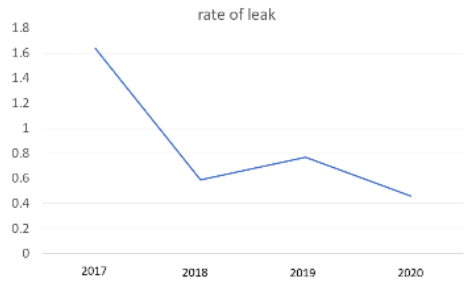
Figure 2. Leak rate — yearly distribution. Figure 2. Leak rate—yearly